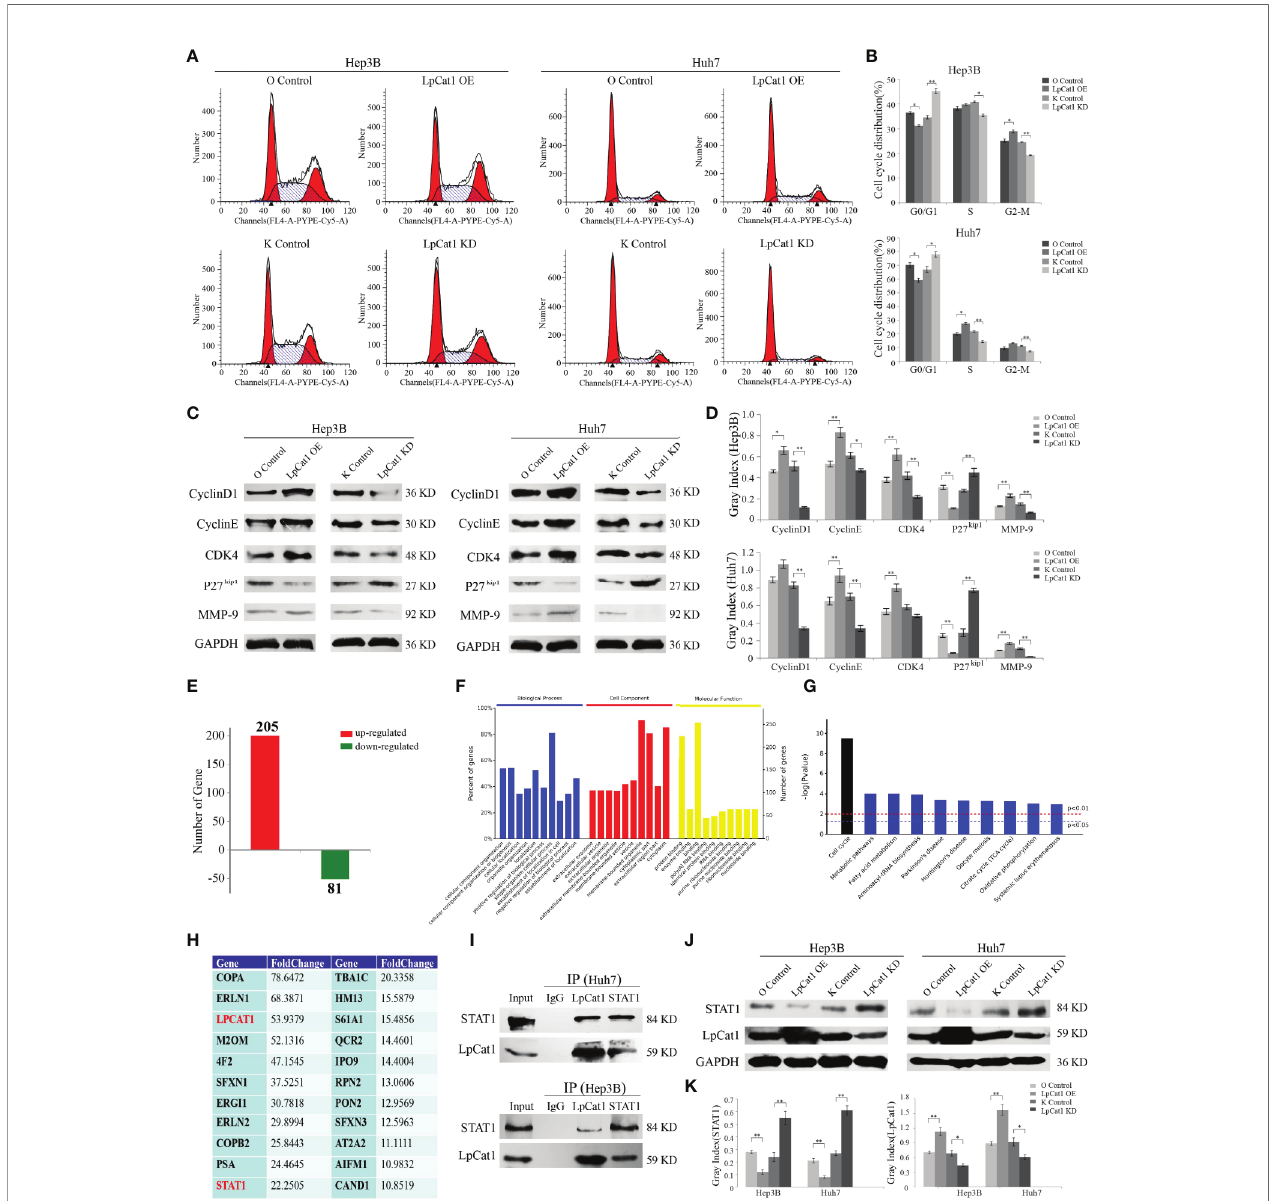
FIGURE 3 | LpCat1 interacted with STAT1 and facilitates cell cycle progression. (A, B) Flow cytometry analysis of cell cycle in the LpCat1 over-expression and knockdown HCC cells. Data of cell cycle were shown in histograms. Data were presented as mean±SD, *p < 0.05, **p < 0.001. (C, D) The expression of cell cycle related proteins was detected by western blotting in HCC cell lines with LpCat1 stably over-expression or knockdown. GAPDH was used as loading control, and bands were semi-quantitatively analyzed by using Image J software, normalized to GAPDH density. Data were presented as mean±SD, *p < 0.05, **p < 0.001. (E) IP-MS analysis of LpCat1-binding proteins. The proteins of LpCat1 OE and OC groups in Huh7 cells were obtained and performed IPs with anti-LpCat1 antibody. The differential proteins identi fi ed by MS analysis between two groups were counted, and the number of genes corresponding to differential proteins was showed in histogram. (F) All these 286 genes were subject to GO term analysis. (G) Enriched KEGG pathway analysis of 286 genes by DAVID. (H) Analyses of identi fi ed proteins precipitated with the LpCat1 antibody (Fold change >10). (I) Co-IP analysis indicated the endogenous interaction between LpCat1 and STAT1 proteins in HCC cell lines. (J, K) Western blotting analysis of STAT1 protein in HCC cell lines with LpCat1 stably over-expression or knockdown. GAPDH was used as internal control. Data were presented as mean±SD, *p < 0.05, **p <